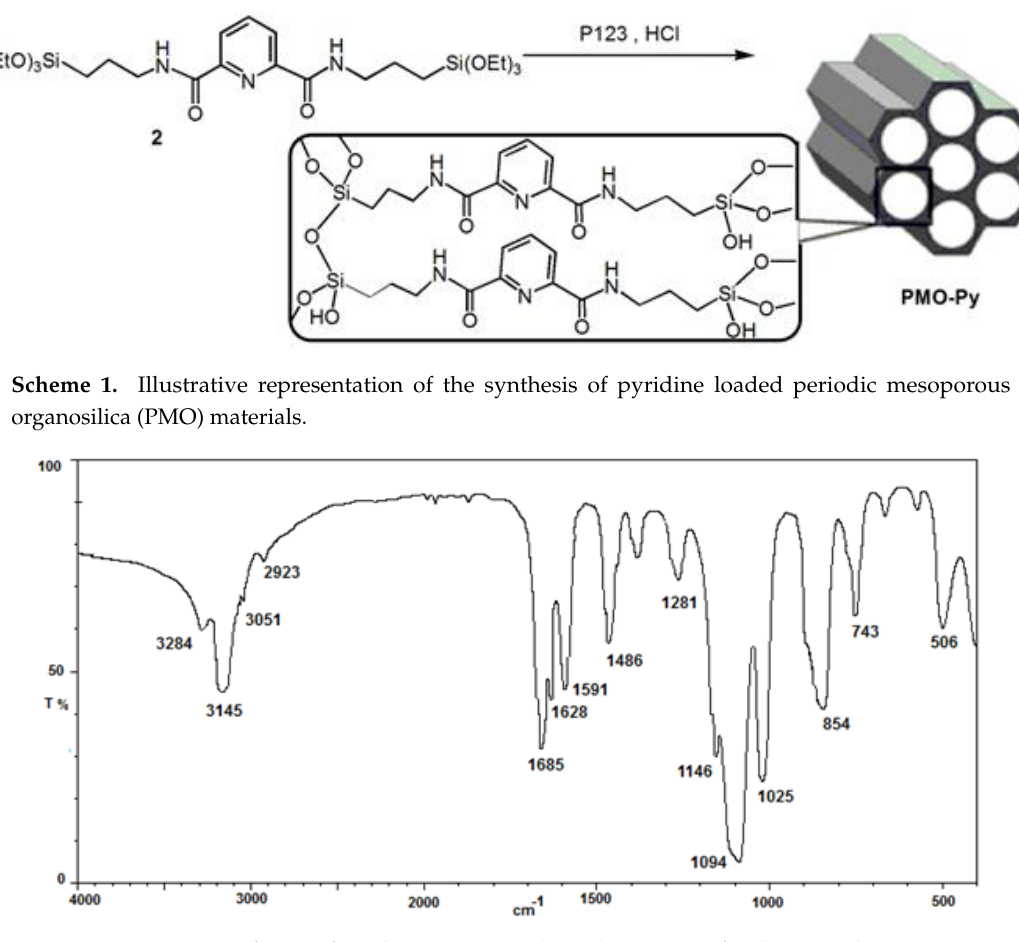
Figure 1. Fourier-transform infrared spectroscopy (FT-IR) spectrum for the periodic mesoporous organosilica (PMO) material bearing pyridinedicarboxamide bridging